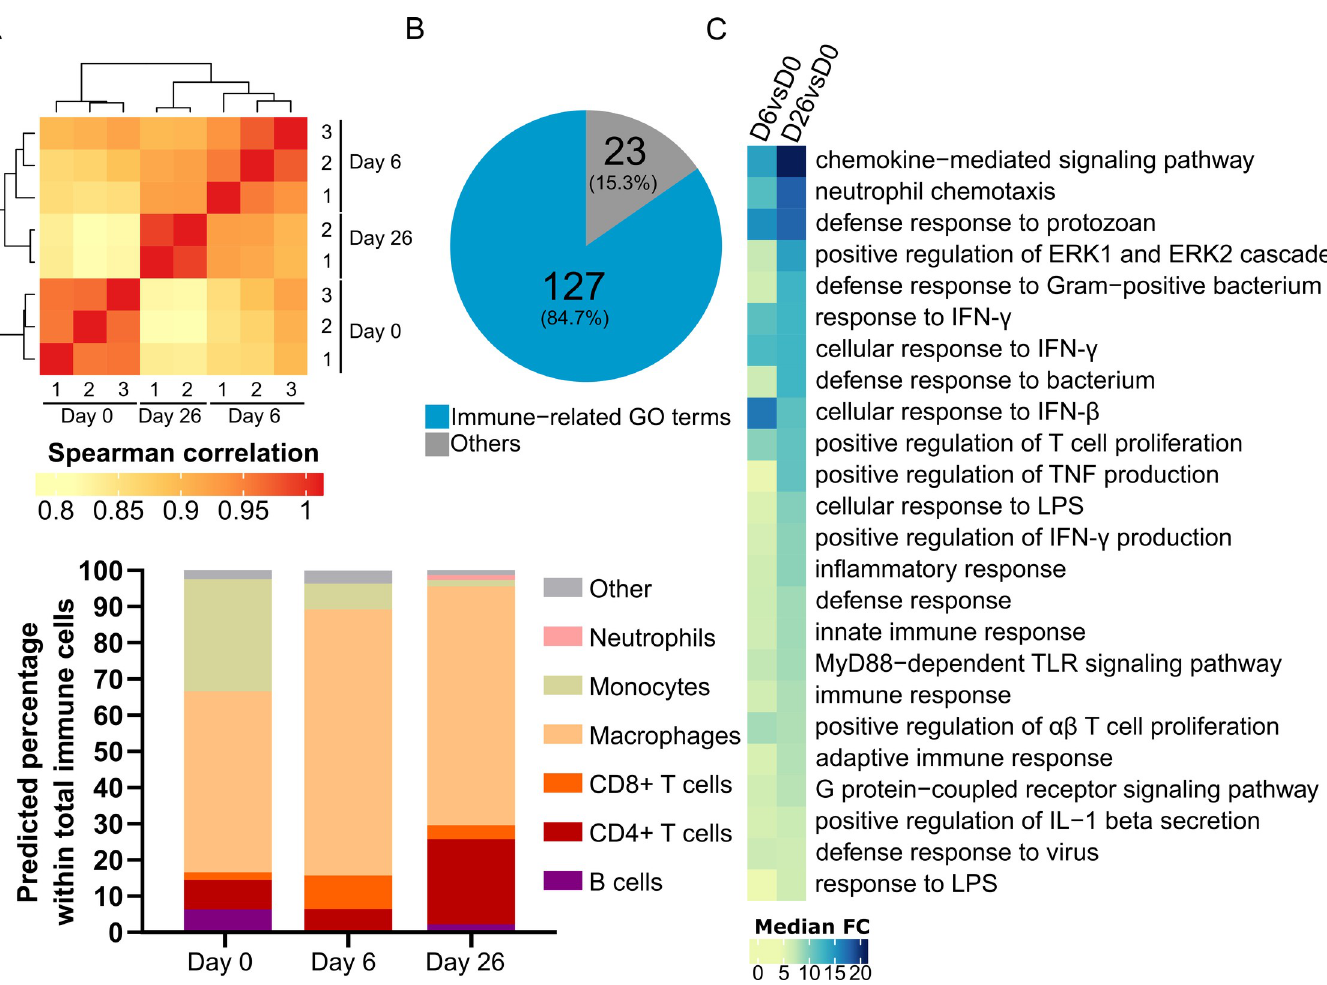
Fig 1. Transcriptome of T . brucei infected AT shows a strong immune response. (A) Heat map of hierarchical clustering of Spearman correlations of Reads per kilobase per million mapped reads (RPKM) levels from non-infected (D0), n = 3 and infected AT at early (D6), n = 3 and late (D26), n = 2 time points. (B) Pie chart of most significant biological processes GO term families. (C) Heat map view of median fold change (FC) of genes associated to the top 20 Biological Process GO terms in day 6 and day 26 of infection versus non-infected AT (D6 vs D0 and D26 vs D0, respectively) (D) Prediction of immune cell distribution based on immuCC RNA-seq